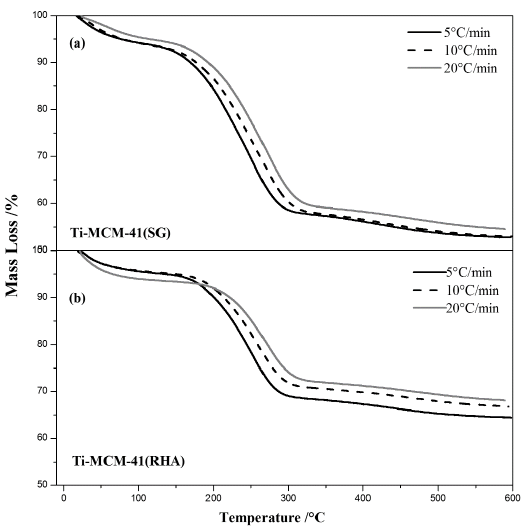
Figure 1. TG curves of (a) Ti-MCM-41 (SG) and (b) Ti-MCM-41 (RHA).